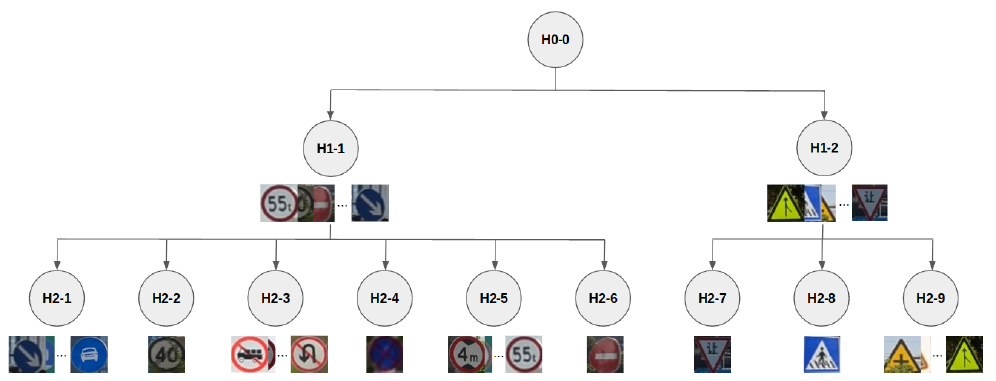
Figure 3. Hierarchy of Tsinghua traffic